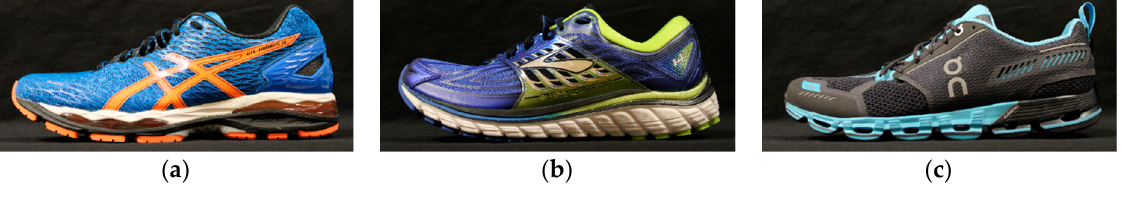
Figure 1. ( a ) Asics GEL-NIMBUS 18, ( b ) Brooks GLYCERIN 14, ( c ) On